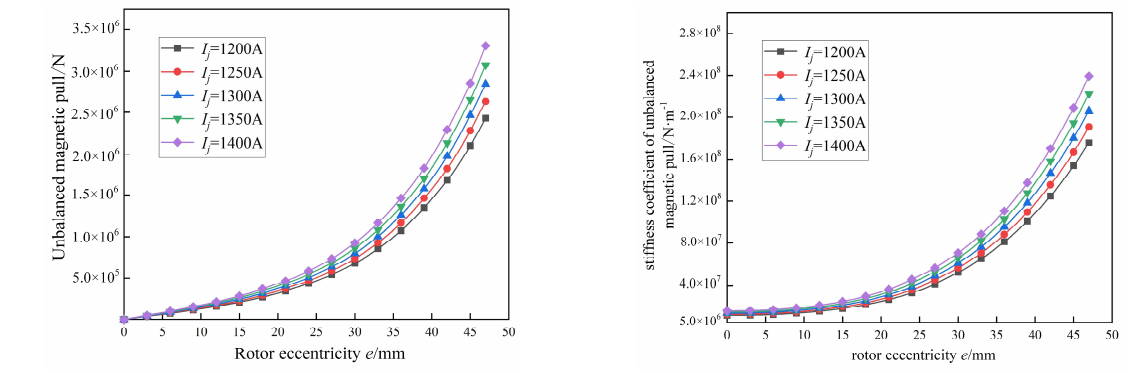
Figure 5. Effect of rotor eccentricity on the magnetic pull of the rotor system.